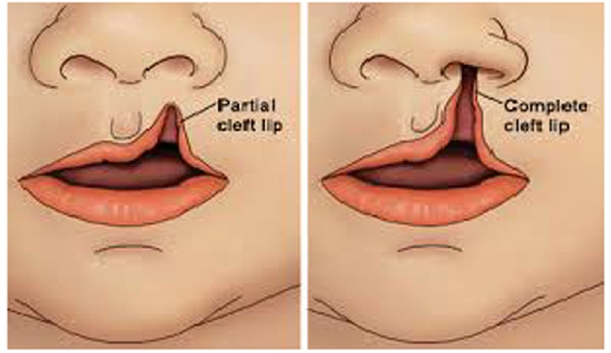
Figure 3: An illustrative drawing of cleft lip types from Ibrahim ’ s